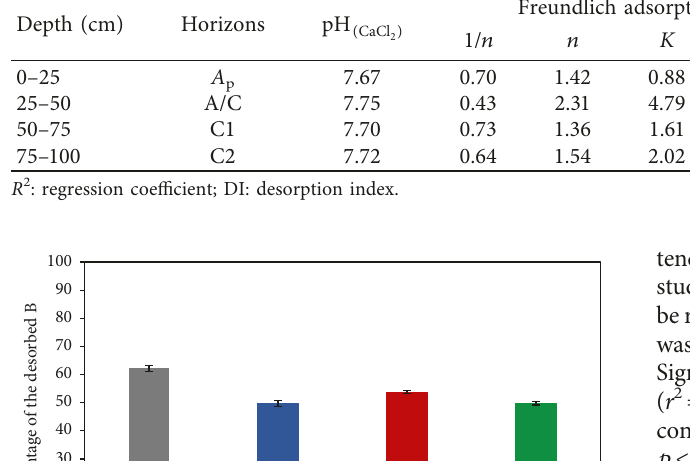
Table 2: Freundlich adsorption and desorption coefficients and desorption index of the studied soil. Depth (cm) Horizons